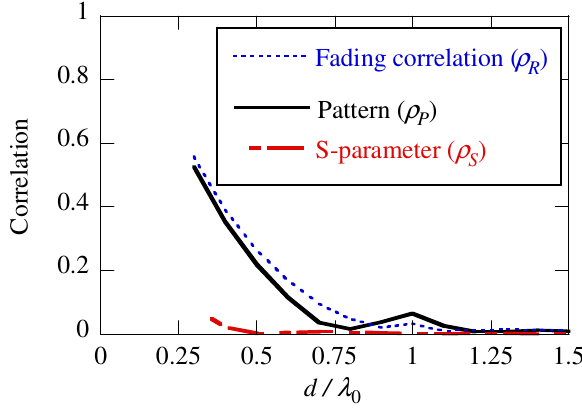
Figure 11. Correlation coefficient versus element spacing d : MSAA ( M =